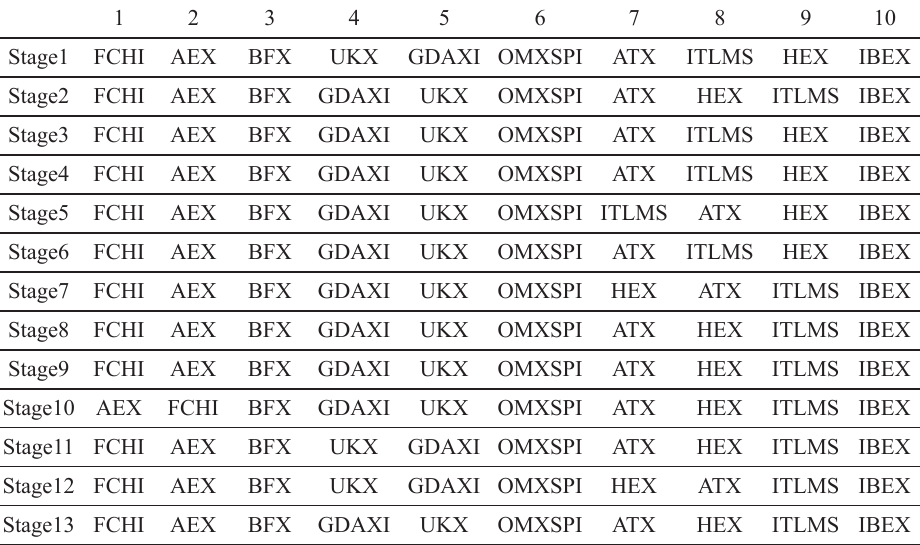
Table 2. Top ten of the average weighted degree’s ranking in each